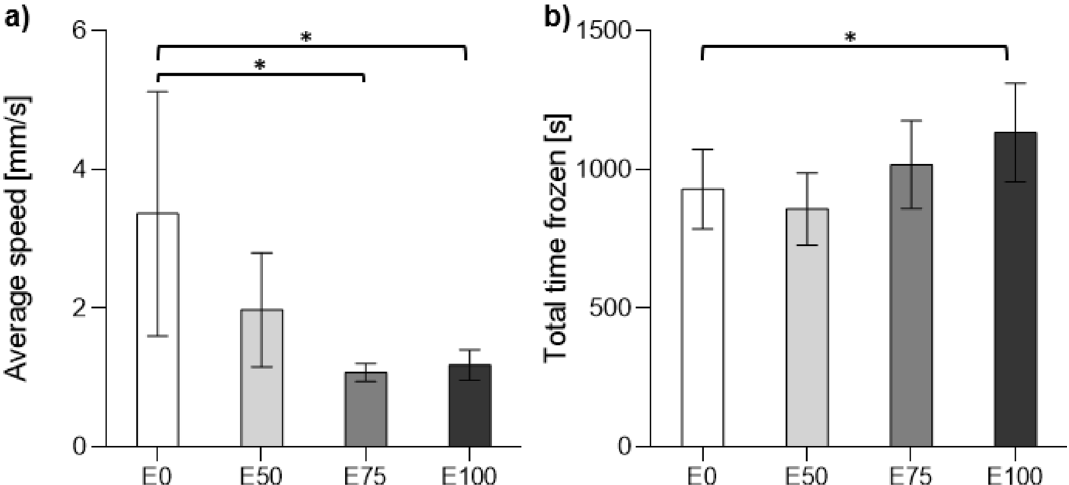
Figure 3. Activity measures. Mean ± SE ( a ) average speed (mm/s), ( b ) total time frozen (s) for damselfly larvae exposed to 0, 50, 75, and 100% effluent (E0, E50, E75, and E100, respectively). Statistically significant differences between control and exposed treatments after exposure are indicated with an asterisk (*p < 0.05).